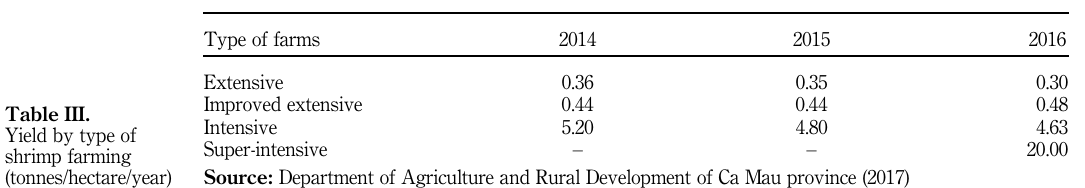
Table III. Yield by type of shrimp farming